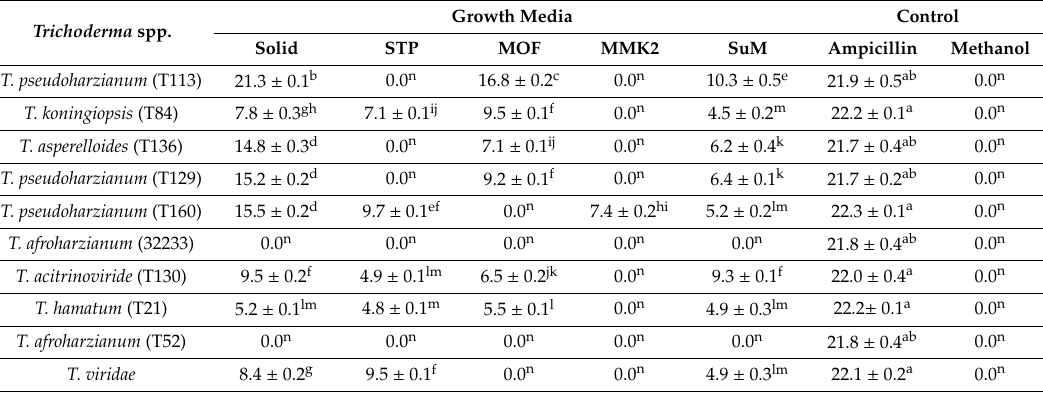
Table 2. Growth inhibition (mm) of X. compestris a ff ected by SMs (obtained on di ff erent growth media) of Trichoderma spp. evaluated through the well di ff usion method. Trichoderma spp.